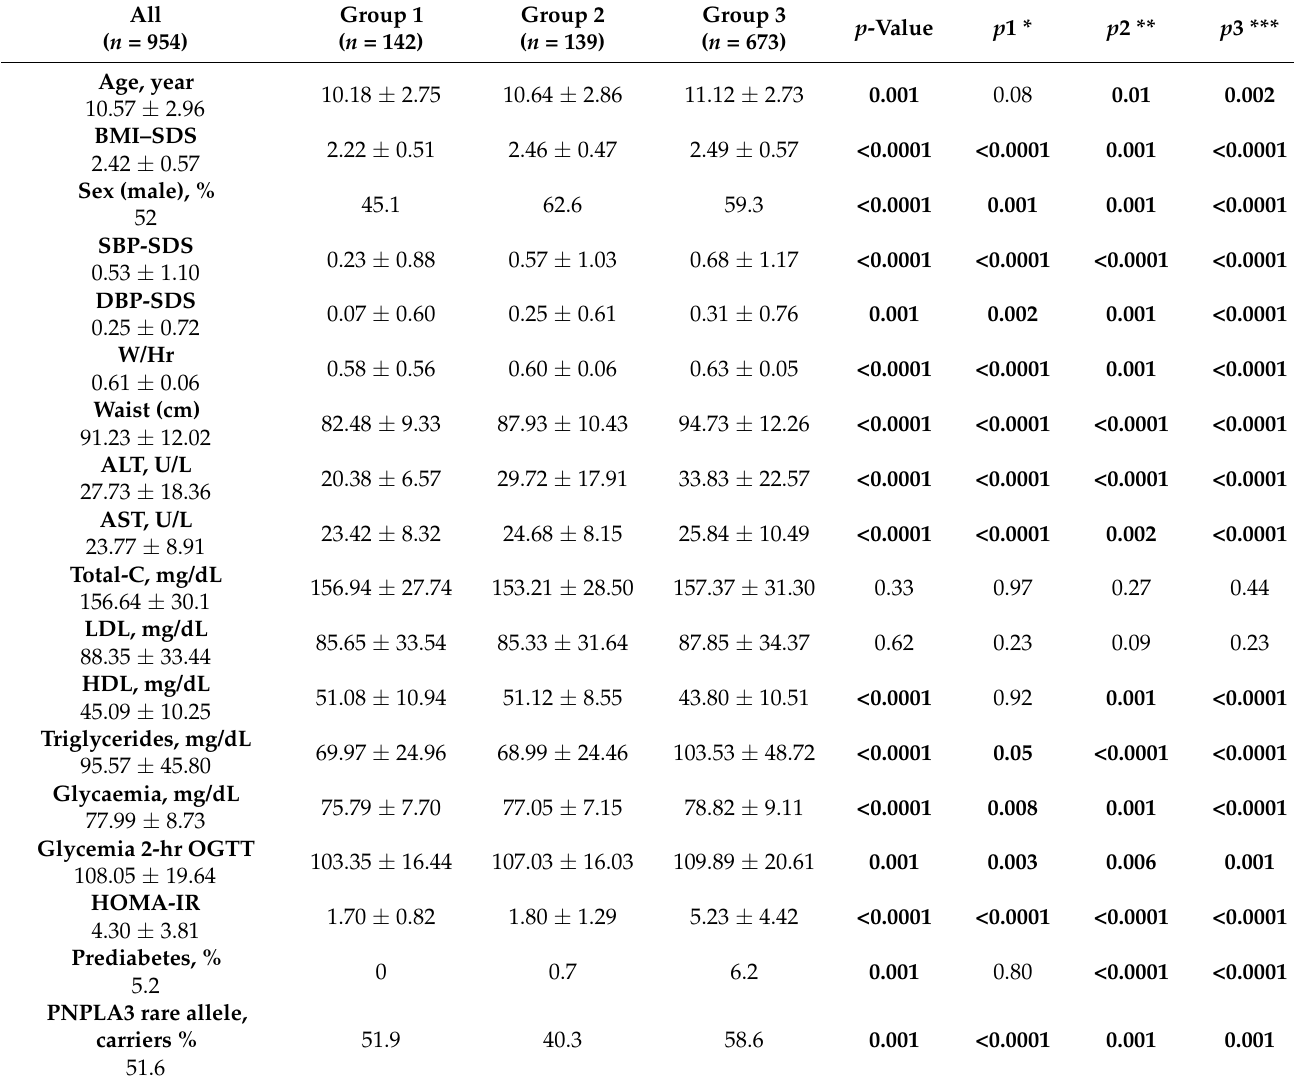
Table 1. Main features of the study population according to the metabolic